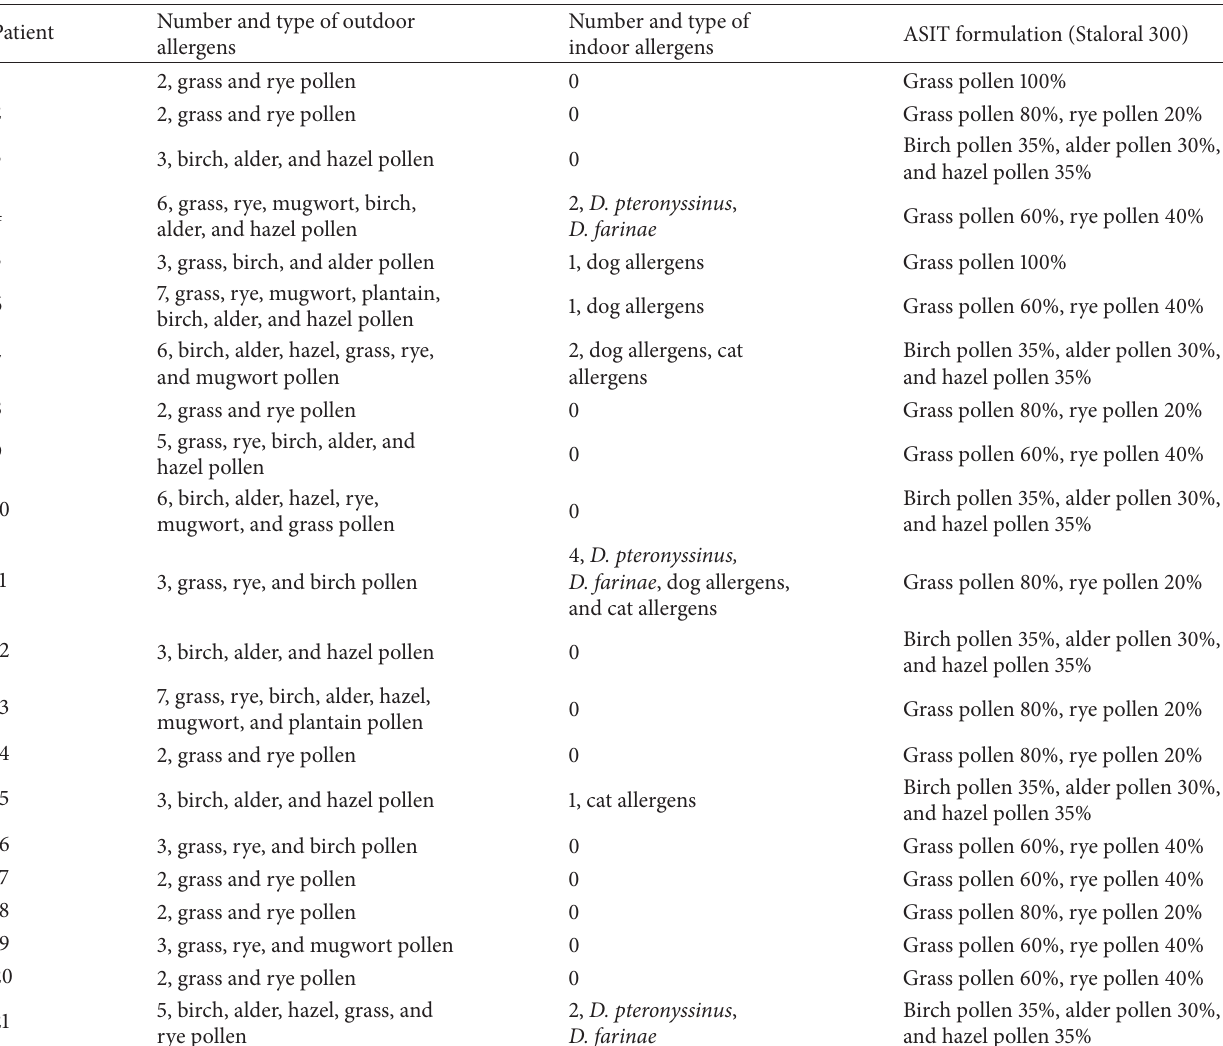
Table 2: Sensitizing antigens and ASIT